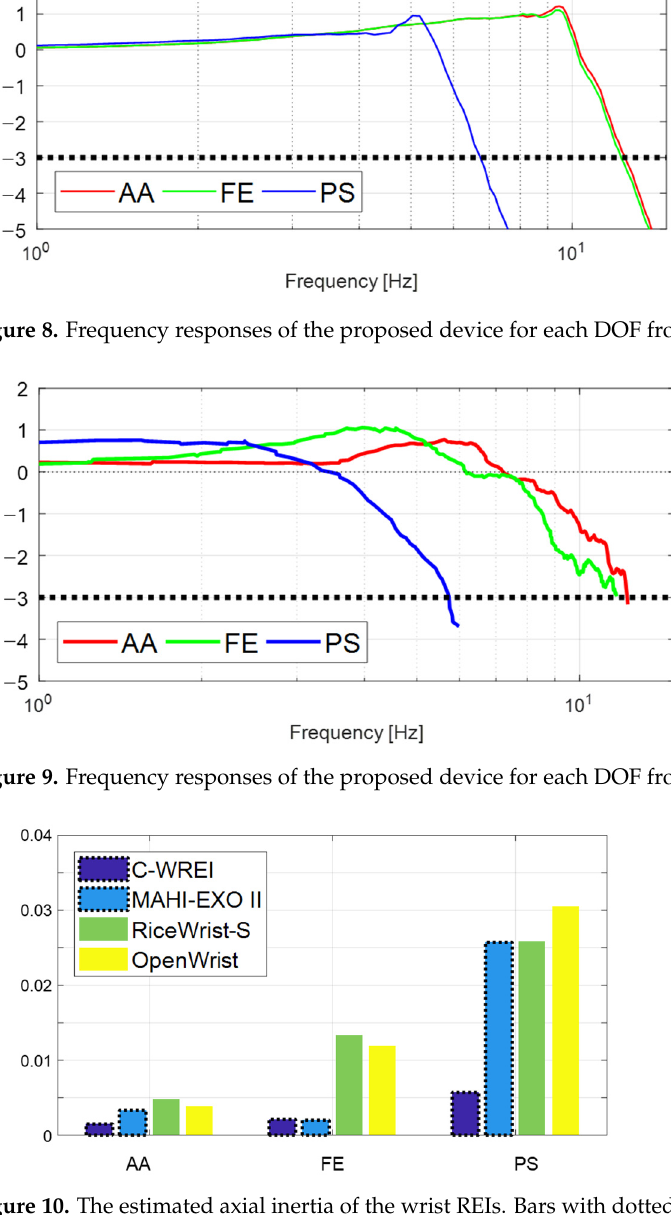
Figure 10. The estimated axial inertia of the wrist REIs. Bars with dotted lines show the inertia of the parallel mechanism-based wrist REIs including the FC-WREI. Table 3. Closed-loop bandwidth frequency and inertia properties of the similar wrist REIs.